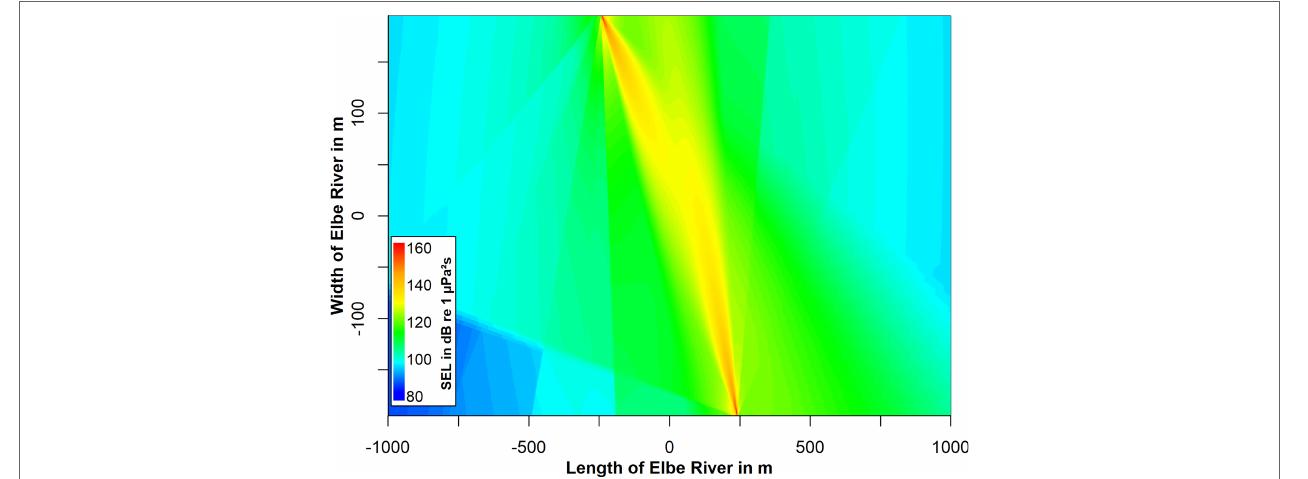
FIGURE 6 | Top view on the combined sound field of the two flowmeters at a depth of 5 m. This combination is derived from summing up the single arrays of the two flow meters. The flowmeters alternately emit pulses with a combined inter-pulse interval of 2 s. The inter-pulse interval of each flowmeter is 4.2 s. The color coded sound exposure level represents a double pulse, meaning a pulse of each flowmeter emitted